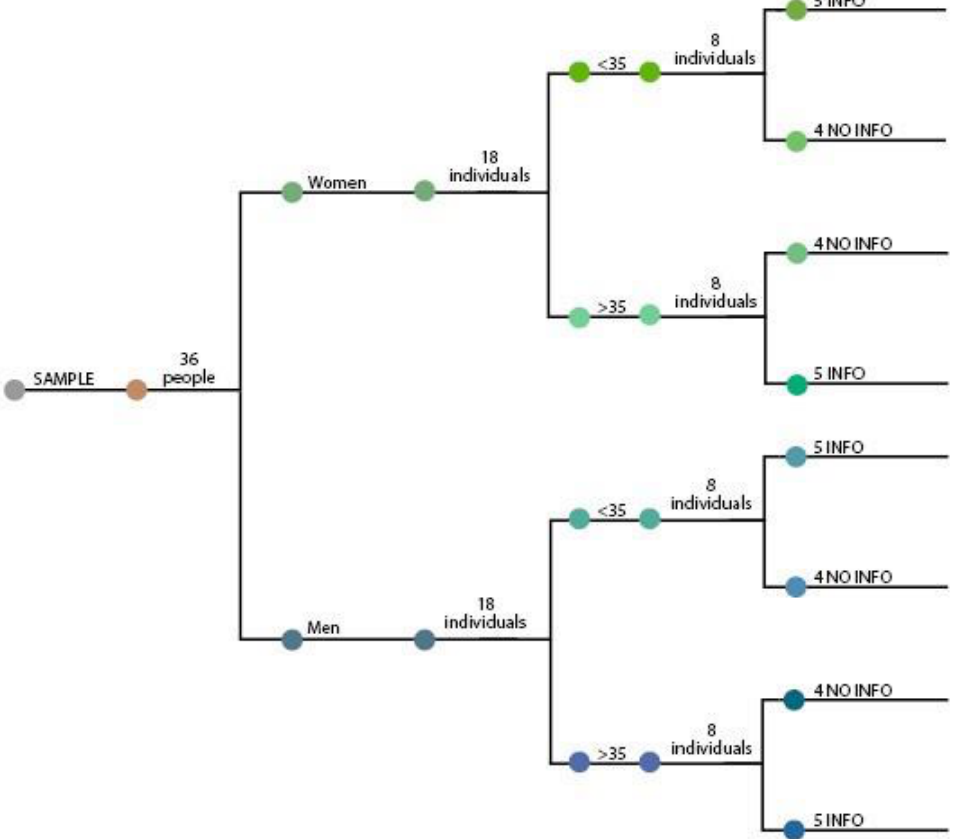
Figure 1. Sample distribution. (For further explanations see the text.)